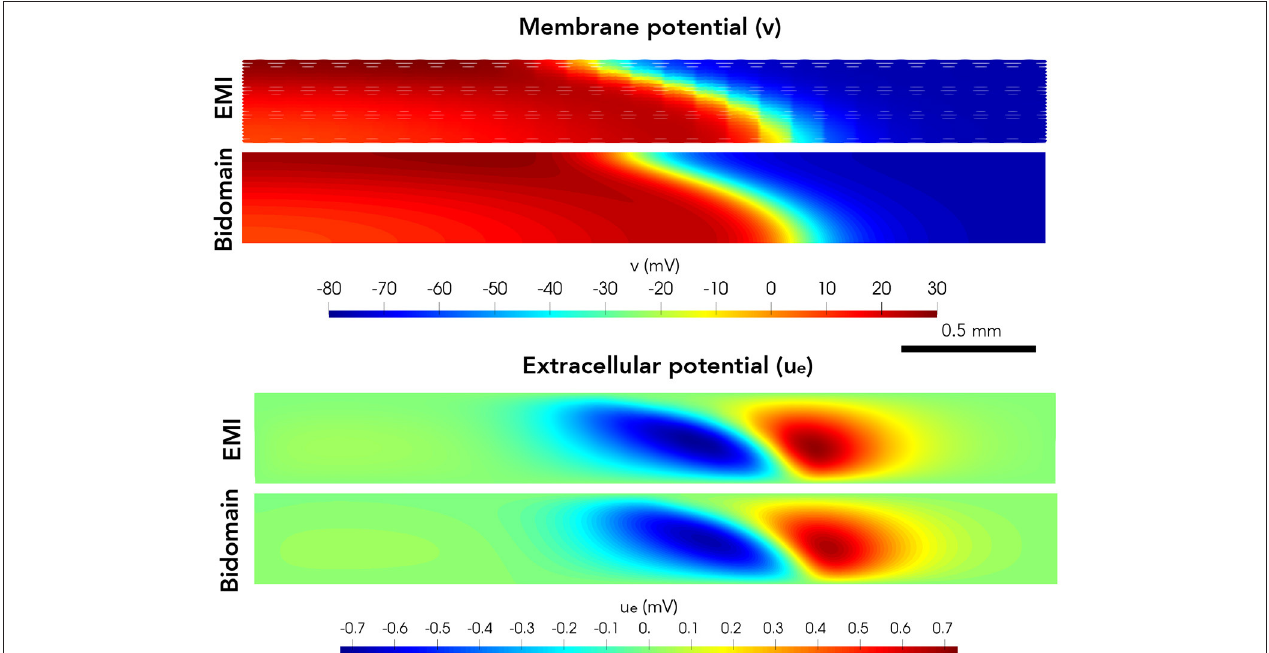
FIGURE 5 | Membrane potential, v , and extracellular potential, u e , at time t = 5 ms in EMI model and bidomain model simulations using the default parameter values specified in Table 1 and an active membrane model ( Jæger et al., 2021b). This simulation required a CPU time of 132 min for the EMI model and 2 min for the bidomain model.